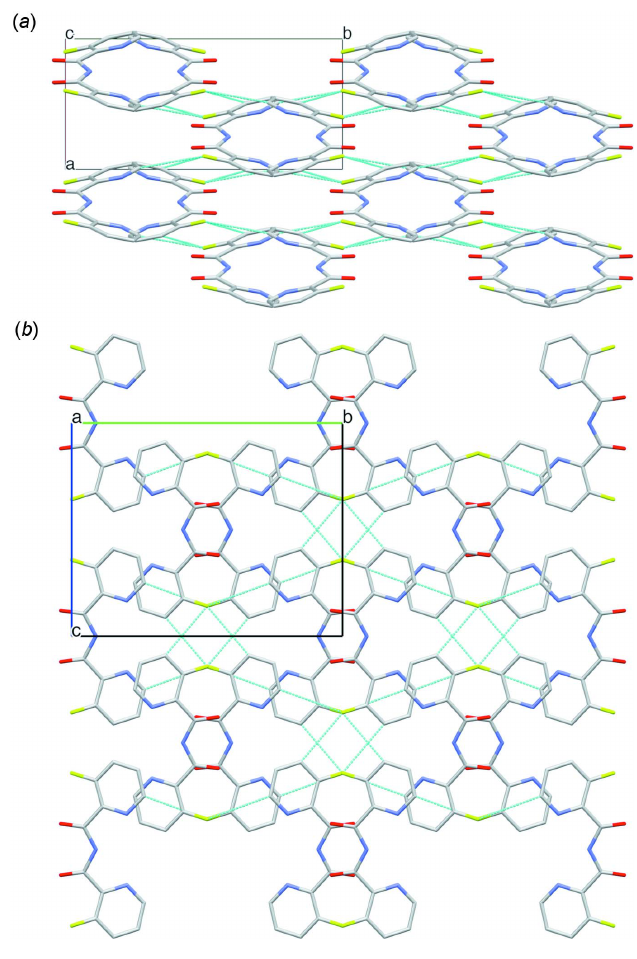
Figure 5 Packing in the structure of 3 , showing ( a ) the longitudinal tubular arrangement of the molecules along the c axis and ( b ) the aromatic pyridine and the carbonyl/fluorine moieties facing towards each other. C5—H5 (cid:4)(cid:4)(cid:4) F1 and C3—H3 (cid:4)(cid:4)(cid:4) F1 hydrogen bonds are indicated. Hydrogen atoms are omitted for clarity.